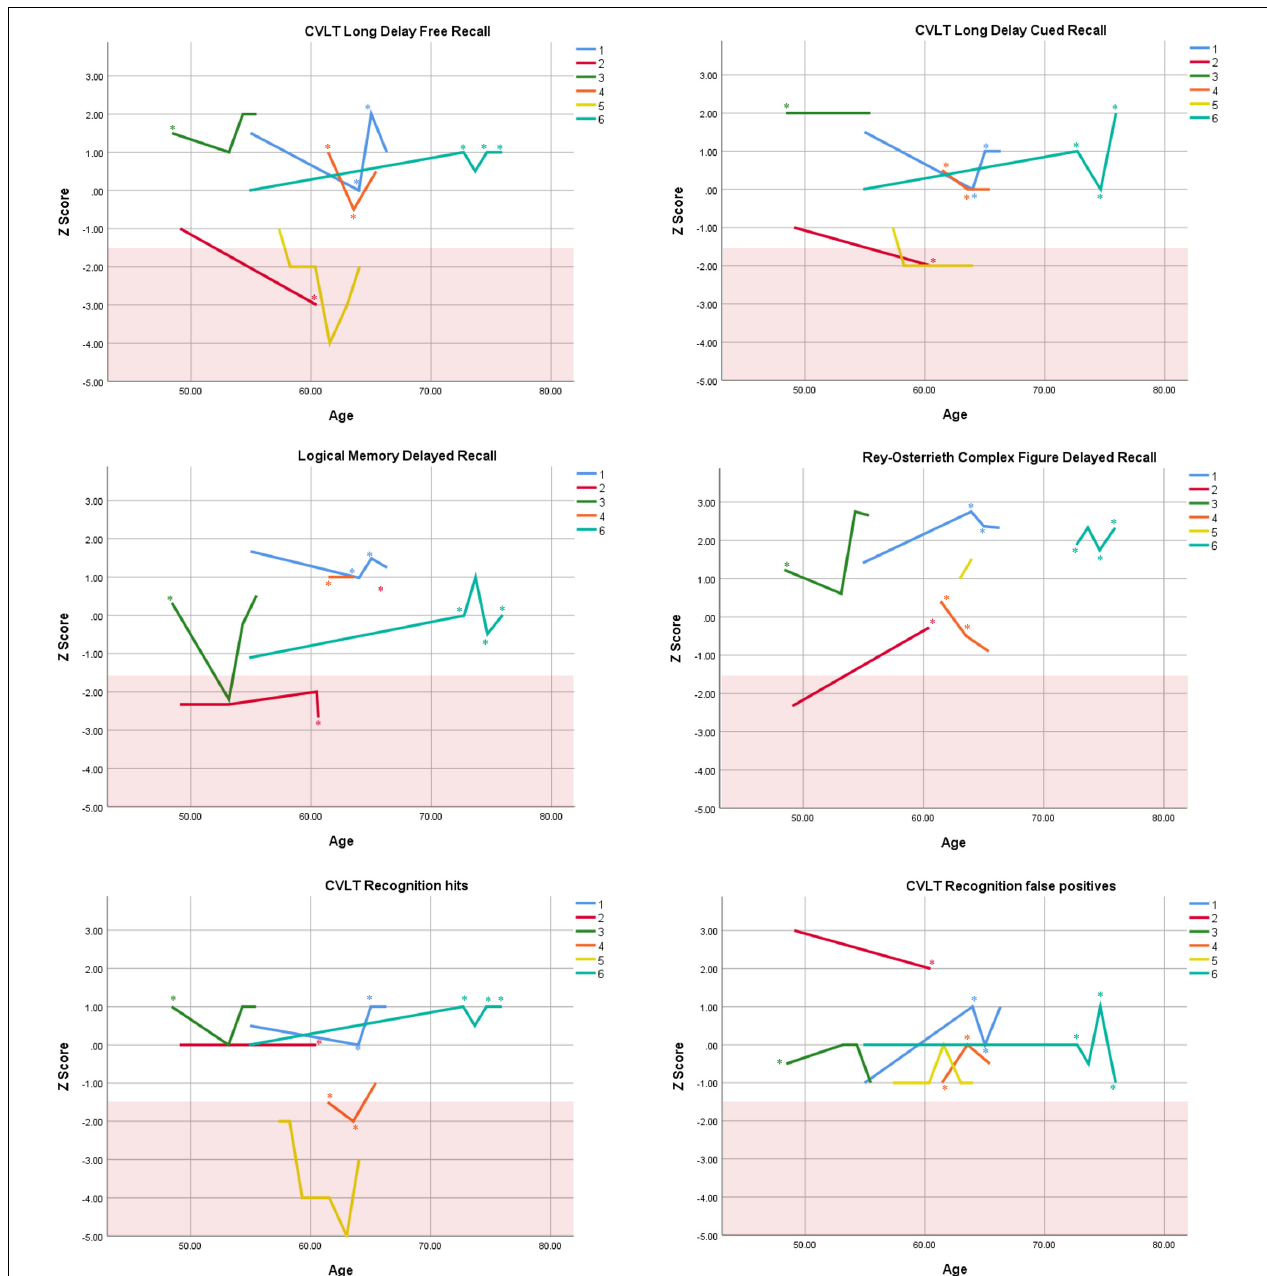
FIGURE 3 | Individual longitudinal performance on measures of delayed recall. Shaded red area represents impaired performance ( Z < –1.5). CVLT = California Verbal Learning Test. *Denotes clinically significant depressive symptoms at that visit (30-item GDS ≥ 10 or BDI-II ≥